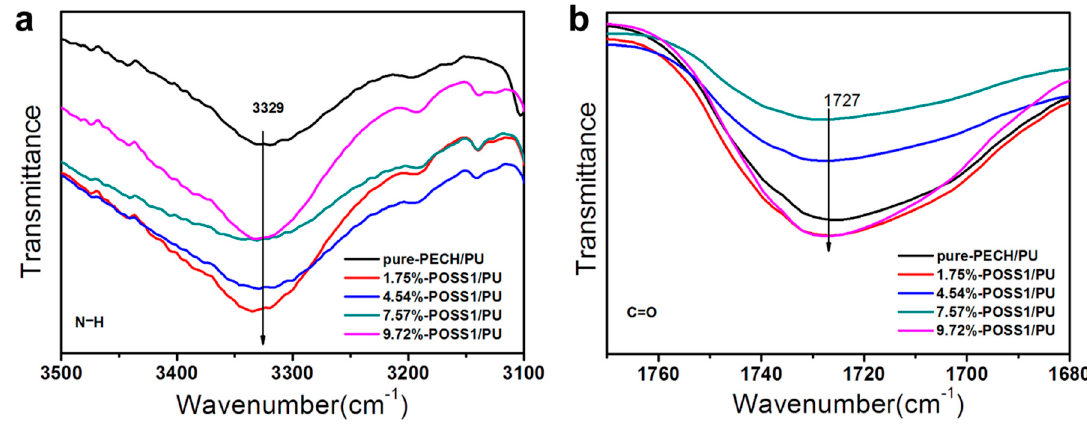
Figure 6. FTIR spectra of the N–H stretching regions and the C=O stretching regions of PUs with different contents of POSS–PECH.